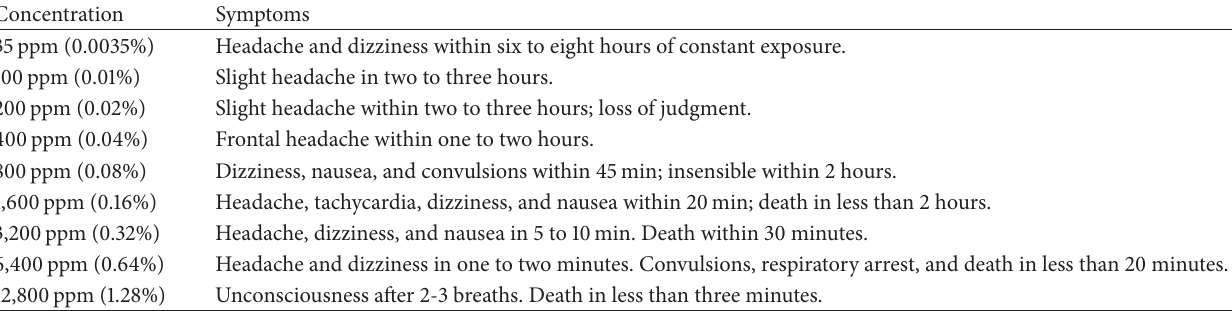
Table 1: Carbon monoxide poisoning: signs and symptoms